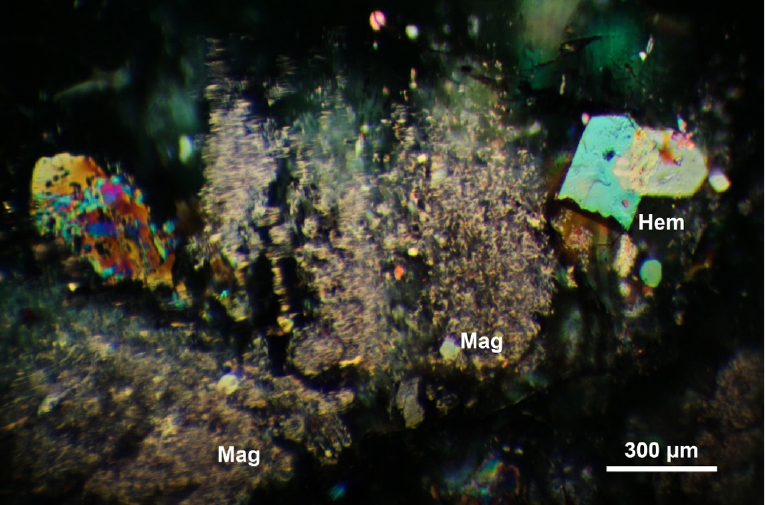
Figure 5. The HRXCT image shows the metal minerals (red circle) and voids (blue circle) in the sample, accompanied by a hexagonal core.